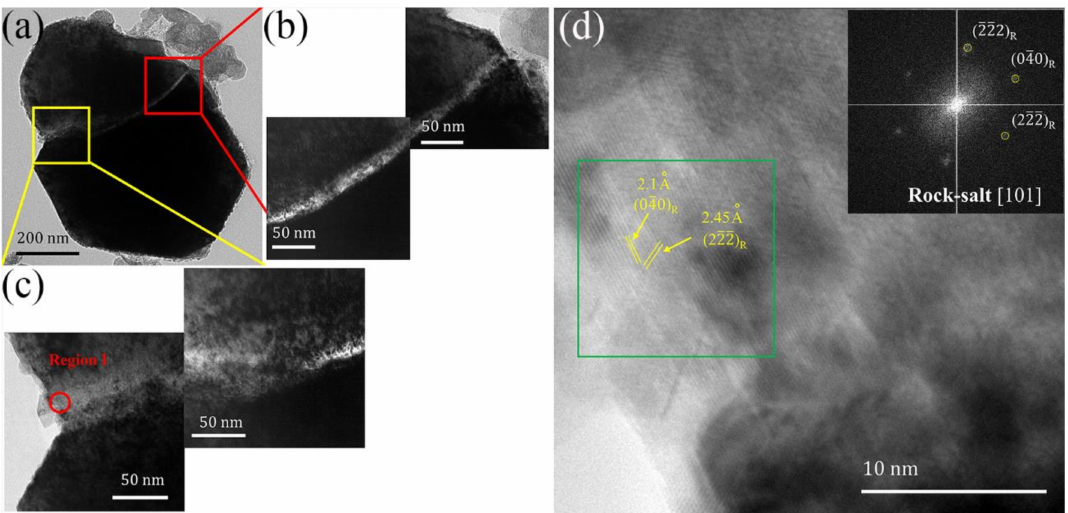
Figure 6. ( a ) The TEM imagine of Li[Li 0.2 Ni 0.13 Mn 0.54 Co 0.13 ]O 2 after 100 cycles between 2 and 4.8 V at 0.1 C rate. ( b , c ) the higher magnification image of the crack in panel. ( d ) The HR-TEM image and FFT pattern (inset) of region I stressed by a red circle in